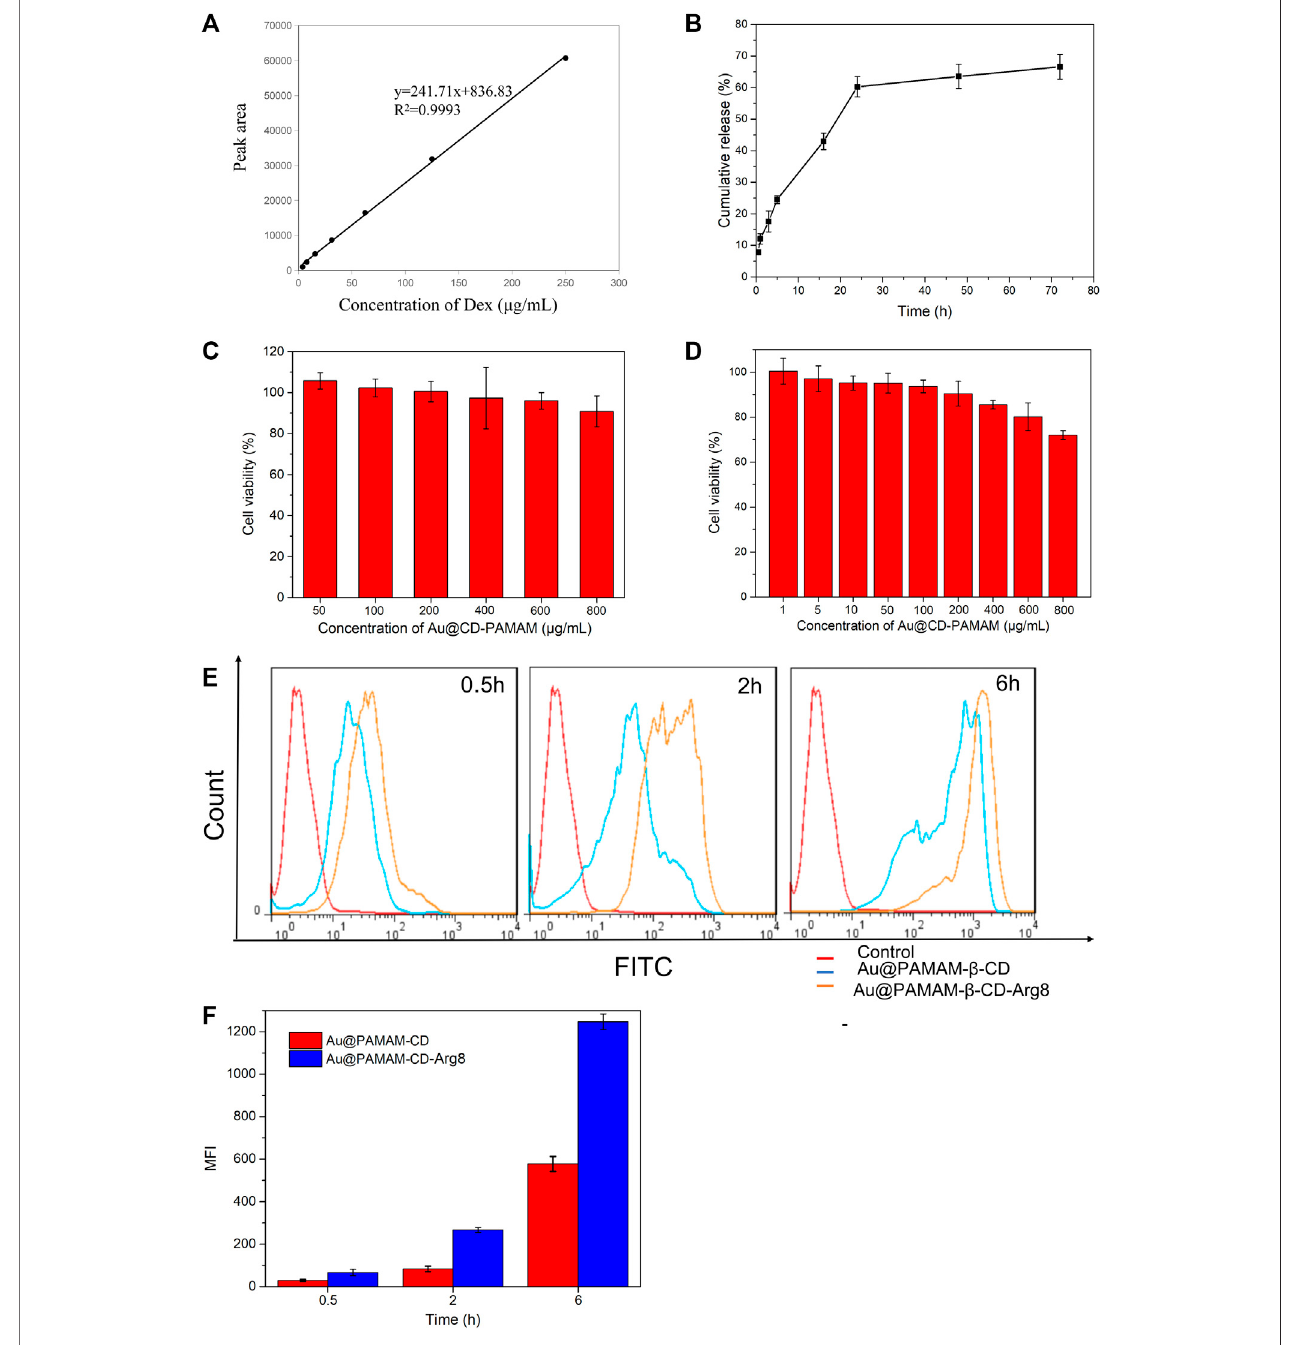
FIGURE 2 | (A) Standard curve of Dex. (B) Release curve of Dex. (C) L929 cell cytotoxicity. (D) HEIOC1 cell cytotoxicity. (E) Targeting of nanoparticle carriers. (F) Quantitative analysis of gold nanoparticles expression in HEIOC1 cells at different time